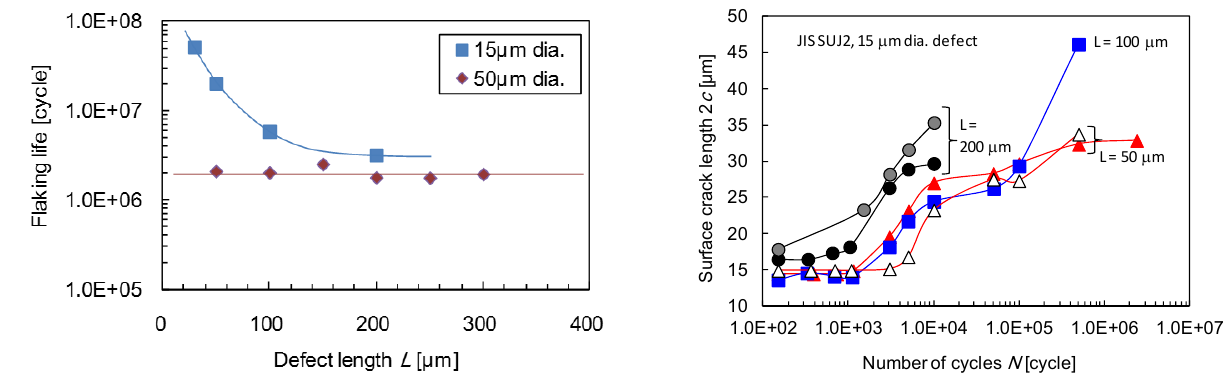
Figure 1: Relationship between defect length and flaking life obtained from RCF test of SUJ2.